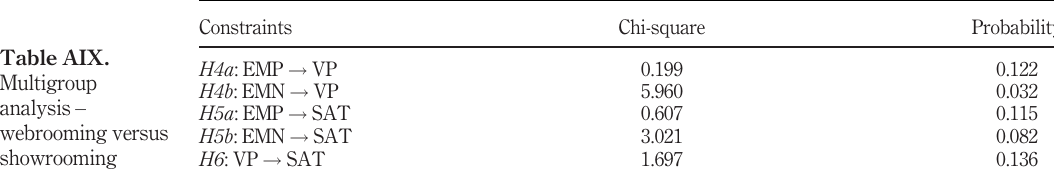
webrooming versus showrooming